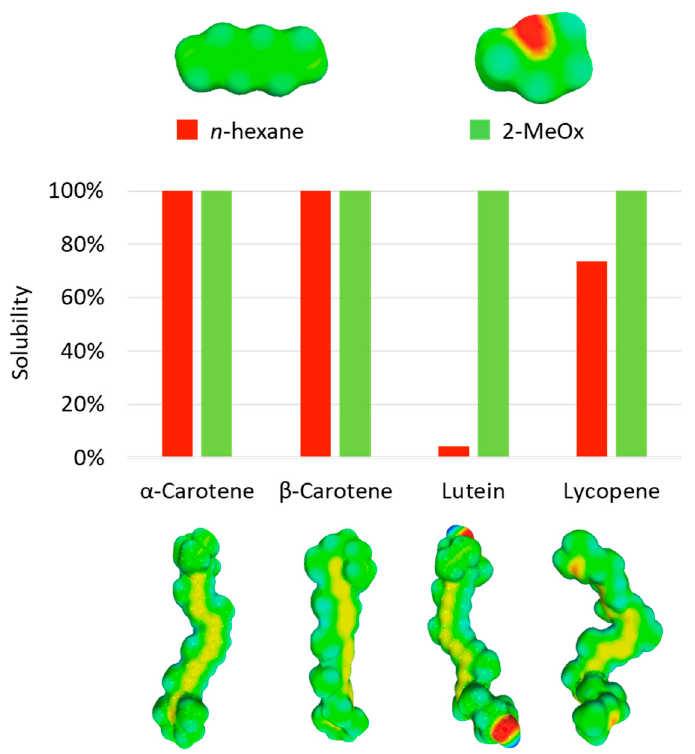
Figure 5. Representation of predicted solubilities of some carotenoids in n -hexane and 2-MeOx from [46] and their corresponding sigma surfaces, given by COSMO-RS. Rating: 0–20% bad solvent; 20–60% average solvent; 60–100% good solvent.